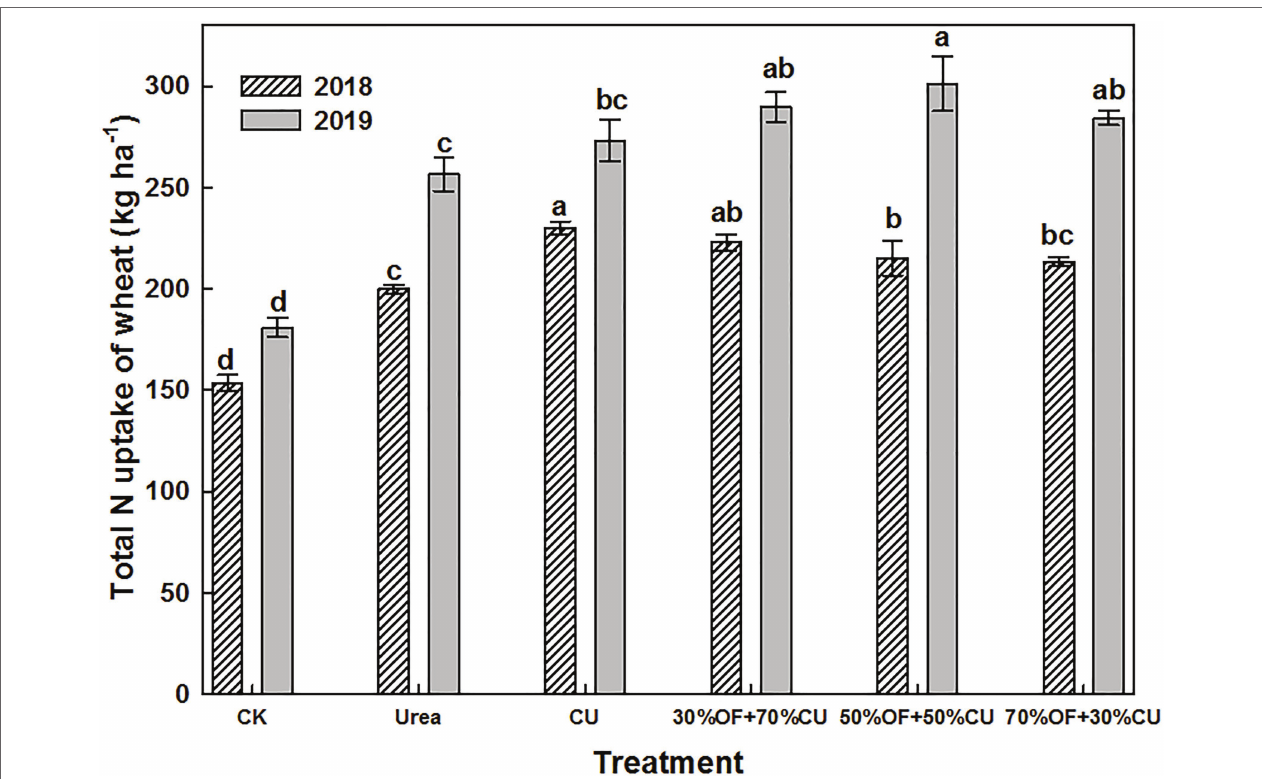
FIGURE 2 | The total N uptake of wheat plants. The error bars indicate the standard errors ( n = 3). The different lowercase letters above error bars indicate significant differences at the p < 0.05 level for each treatment in the same year.